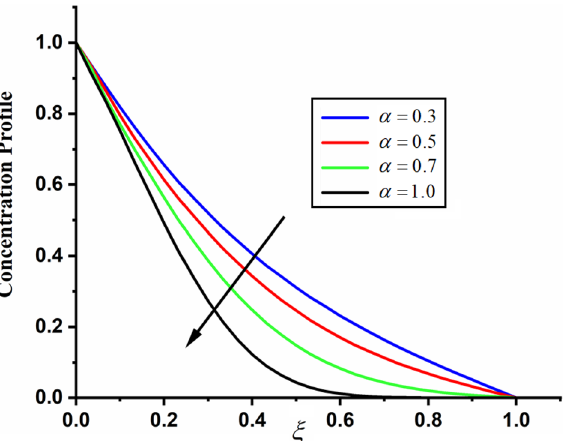
Figure 17. The impact of α on couple stress fluid concentration profile when, β = 0.5 , t = 0.2 , Sc = 0.5 and Re = 3 .